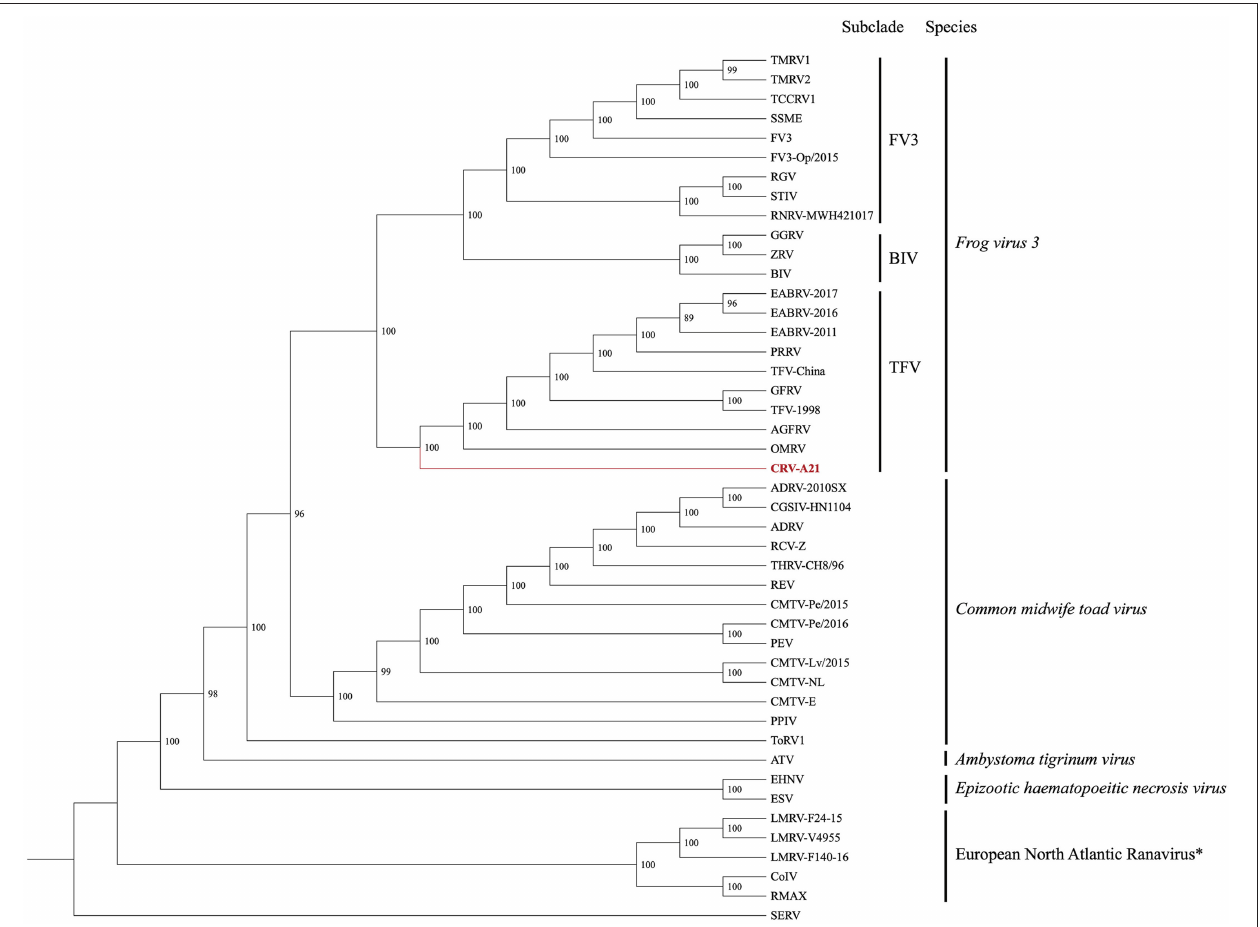
FIGURE 2 | Cladogram illustrating the relationship of the newly sequenced Chad ranavirus (CRV-A21) to members of the genus Ranavirus (Family Iridoviridae ; Subfamily Alphairidovirinae ). The Maximum Likelihood (ML) phylogenetic analysis included the aligned genomes (concatenated locally collinear blocks) of 44 ranaviruses. Clade support was assessed by running 1,000 bootstrap replicates with values presented at each node. See Supplementary Table 1 for virus abbreviations. *Note: European North Atlantic Ranavirus has not been approved as a ranavirus species by the